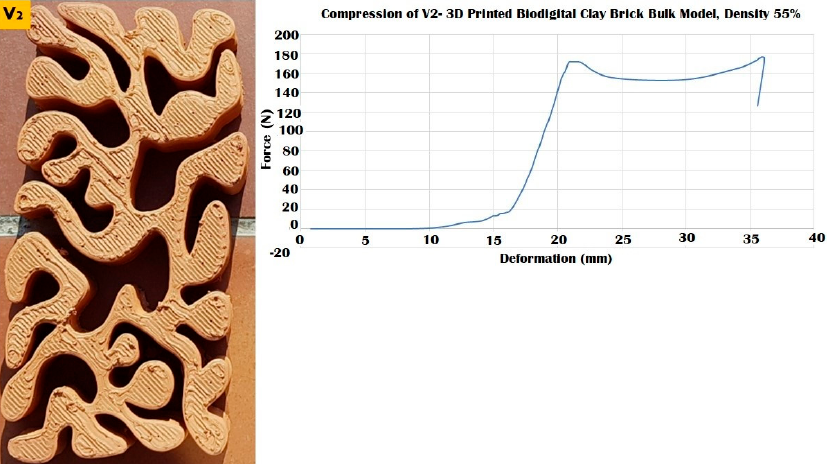
Figure 13. Exhibits the bulk brick model of the V1 family of the biodigital clay bricks with 55% density in the physical 3D-printed model ( left ). The graph exhibits the results of the compression test for this brick, showing the relation between force (N) ( Y -axis) and deformation (mm) ( X -axis). The maximum durability of the V1 bulk brick model achieved up to 240 N before cracking and maintaining its resistance under the same force value without collapsing. This behaviour by the V1 bulk brick model is congruent with its linear model that also resisted until 240 N before it started to break. The linear model of the V1 collapsed under the same force value after resistance, unlike the bulk model that survived the compression test without collapsing. The compression resistance of the V2 bulk brick model of 53,014.6 mm2 surface area was better than its linear model resistance. (Figure 14), as it resisted until 170 N before its first breaking point and maintained resistance at deformation values from 20–35 mm under 150–170 N before it totally collapsed at 36 mm deformation under 170 N with an apparent strain of 0.8 and compressive modulus of 0.004. In contrast, the linear model of the V2 only resisted until 110 N.